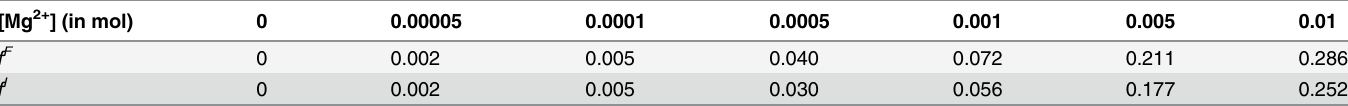
Table 3. The table lists the calculated average binding fraction of the T2 pseudoknot (the folded state, f F ) and the intermediate state ( f I ) under the different [Mg 2+ ] conditions. [Mg 2+ ] (in mol)